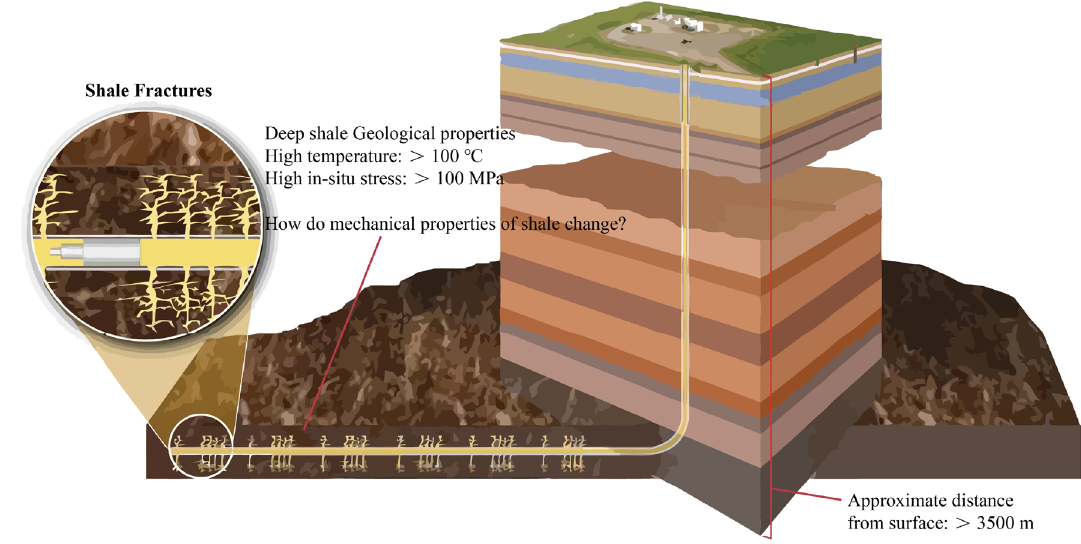
Fig. 1 Geological environment of deep shale (modified from Department of Energy